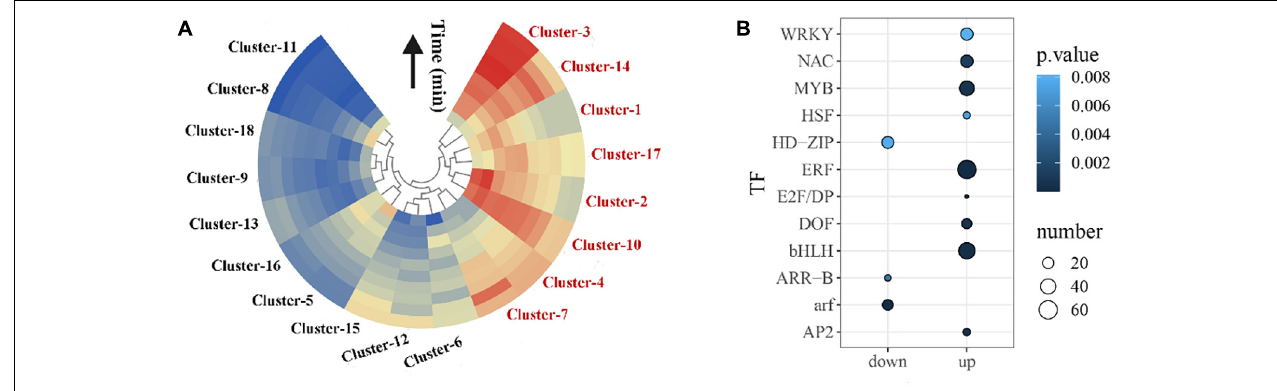
FIGURE 2 | Clustering of co-expressed genes in the wounding response gene regulatory network. (A) A total of 18 distinct clusters that share similar expression dynamics were yielded using the Mfuzz package in R. The mean gene expression profile for each cluster was visualized with a heat map. Red and blue indicate up- and down-regulation of expression [log2 (fold change)]. Fold change = Y-Group/M-Group (e.g., Y-5/M-5). (B) Significantly overrepresented TF families in all clusters t (hypergeometric test; p <